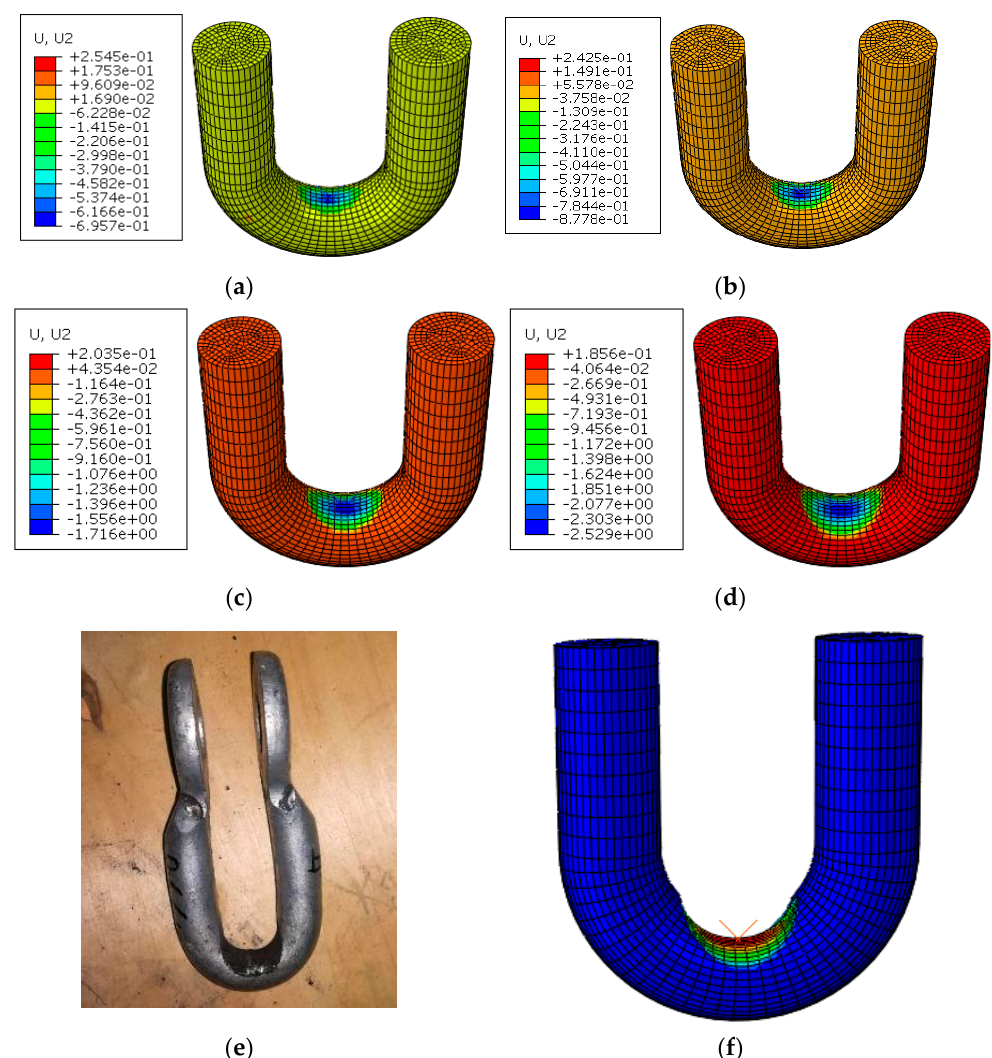
slowed down, between 80,000 to 120,000 times. The decline of wear depth is mainly con- centrated on both sides of the wear central area; hence the growth of wear depth is slowed down. Figure 14. Change of wear depth with wear time, ( a ) 20,000 times; ( b ) 30,000 times; ( c ) 50,000 times; ( d ) 70,000 times; ( e ) 80,000 times; ( f ) total deformation at 80,000 times.